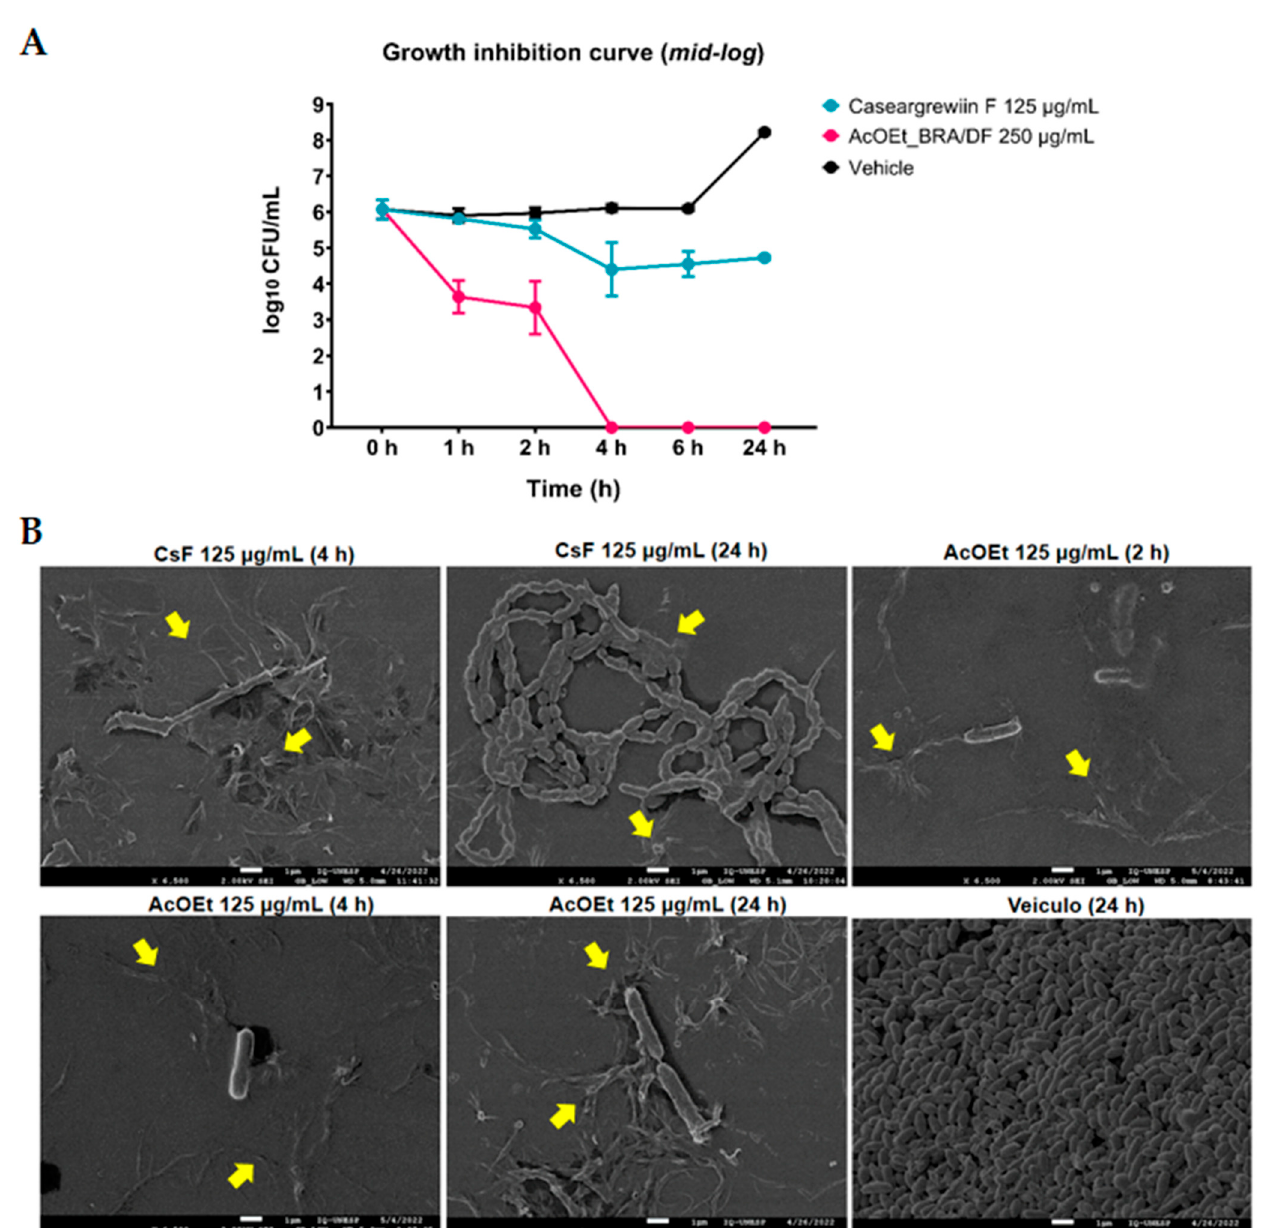
Figure 8. Effects of AcOEt and CsF on planktonic cultures of S. mutans . ( A ) The central data for each time, for each evaluated treatment, are the means and the confidence interval (CI 95%) for error bars; ( B ) representative SEM images of S. mutans planktonic cells after different exposure times to CsF and AcOEt. The arrows indicate amorphous material from ruptured cells. Scale bars are 1 µm. The concentration of the control vehicle in each well was 5.26% EtOH and 0.94% DMSO.